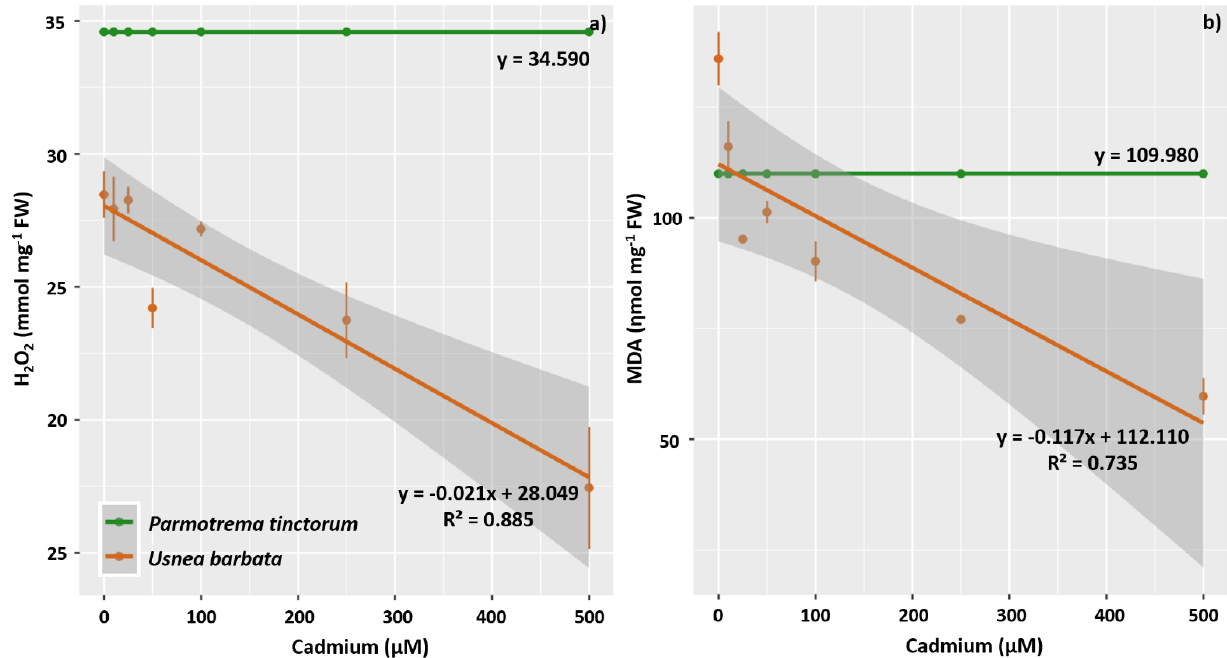
Figure 11. Concentrations of peroxide (H 2 O 2 ) ( a ) and malondialdehyde (MDA) ( b ) observed in the thalli of the lichen species Parmotrema tinctorum and Usnea barbata subjected to different concentrations of Cd (0, 10, 25, 50, 100, 250, and 500 µM). The straight lines represent the fitted model, and the prediction intervals (95%) are gray.